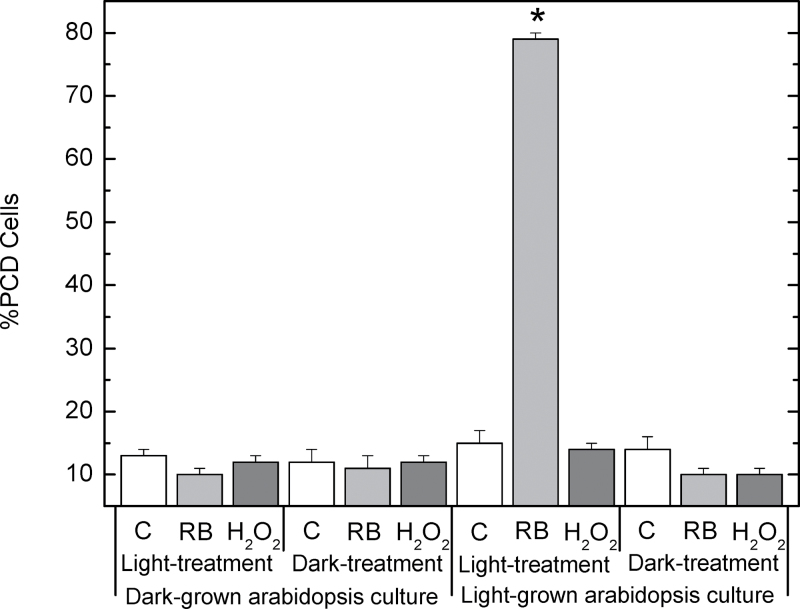
PCD in light-grown and dark-grown Arabidopsis cells subjected to 30min chemical treatments at 150 μE m−2 s−1 or in the dark. Black bar, 0.5 μM RB; grey bar, 500 μM H2O2; white bar, control samples. *P-value <0.05.